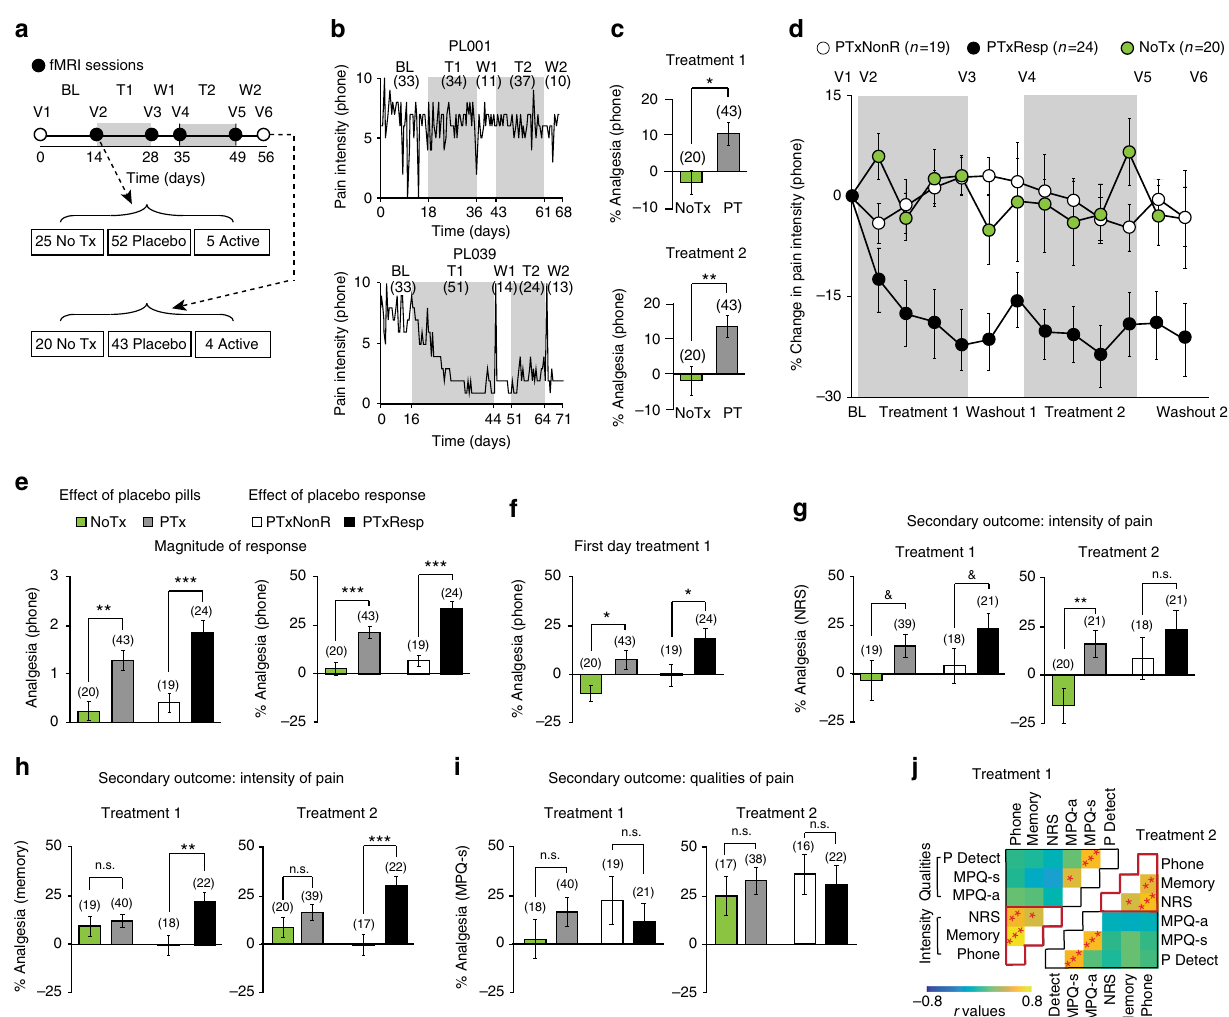
Fig. 1 Placebo pill ingestion diminishes back pain intensity while trial participation non-speci fi cally decreases qualitative pain outcomes. a Experimental design and time line: CBP patients entered a six-visit (V1-6) 8-week randomized controlled trial, including baseline (BL), treatment (T1, T2), and washout (W1, W2) periods. Participants entering and completing the study are indicated. b Example time series of smartphone app pain ratings in 2 patients (values in parentheses are numbers of ratings). c The patients receiving placebo treatment (PTx) showed lower pain levels during the last week of each treatment period, compared to the patients in the no treatment arm (NoTx). d Within-subject permutation tests between pain ratings entered during BL and T1 or T2 identi fi ed responders in PTx and NoTx groups. The group-averaged %change in phone app ratings of back pain intensity (2 bins/week) is displayed in d . e The magnitude of response represents the stronger response between the two treatment periods and is displayed in original score (left) and after conversion in %analgesia (right). f Placebo analgesia was present the fi rst day after placebo pill ingestion. g , h Pain intensity decreased by about 20 – 30% for numerical rating scale (NRS) and memory during both treatment periods. i Qualitative outcome measures (McGill pain questionnaire, MPQ-sensory) decreased in time similarly in all groups, including the NoTx and PTxNonR. j Principal component analyses clustered pain outcomes into 2 factors, segregating intensity and quality. Group by time by Pain (intensity vs quality) interaction indicated that only the pain intensity was diminished by placebo pill ingestion. In c – i number of subjects are in parentheses, & p < 0.12; * p < 0.05; ** p < 0.01; *** p < 0.001, n.s. not signi fi cant. Error bars indicate SEM. For each fi gure, a description of the analyses and p -values are reported in Supplementary Table